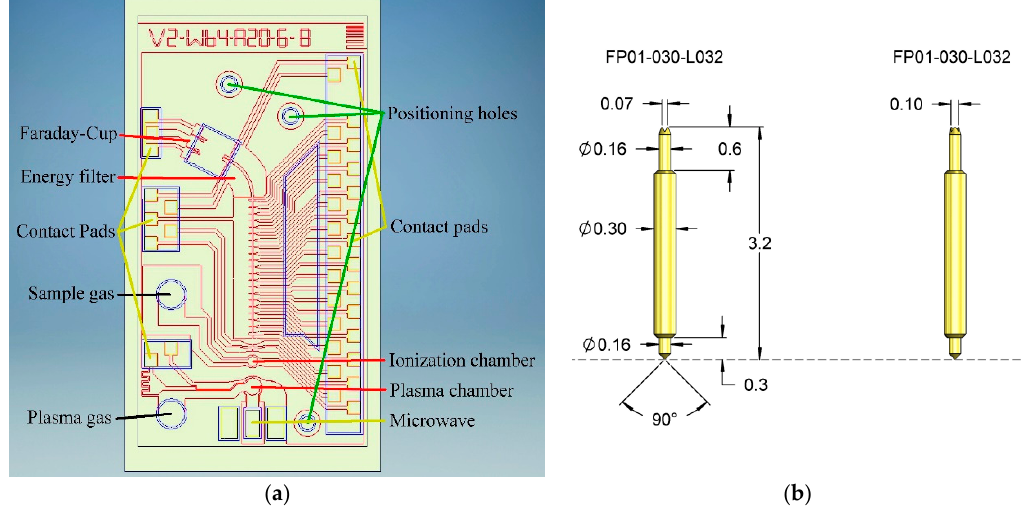
Figure 1. ( a ) Design of exchangeable MEMS-chip; ( b ) dimensions of the used spring-loaded pins in mm